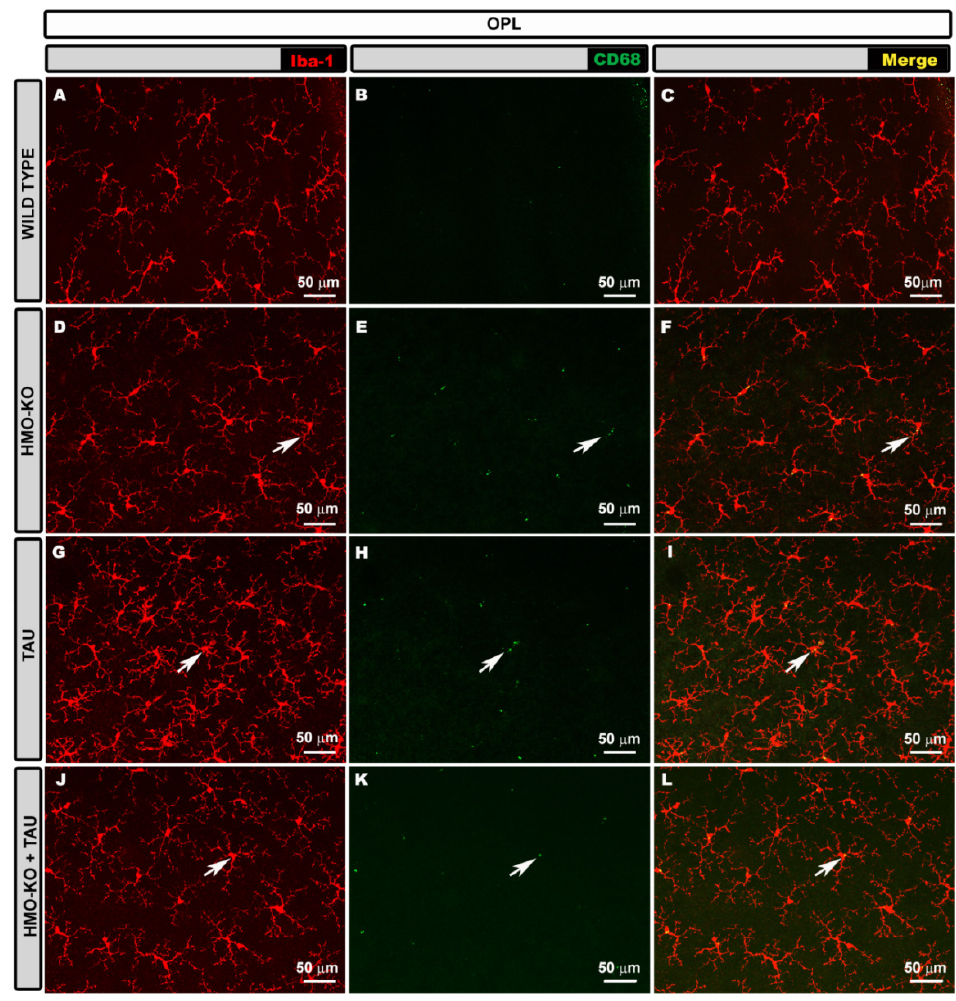
Figure 3. Retinal wholemount. Double immunostaining with anti-Iba-1 (red) and anti-CD68 (green) in OPL in the different study groups: WT ( A – C ), HMO-KO ( D – F ), TAU ( G – I ), HMO-KO+TAU ( J – L ); 20× magnification. Arrows indicate microglial cells with CD68+ labelling. Number of retinas used in the experiment: WT n = 6, HMO-KO n = 6, TAU n = 6, and HMO-KO+TAU n = 6.